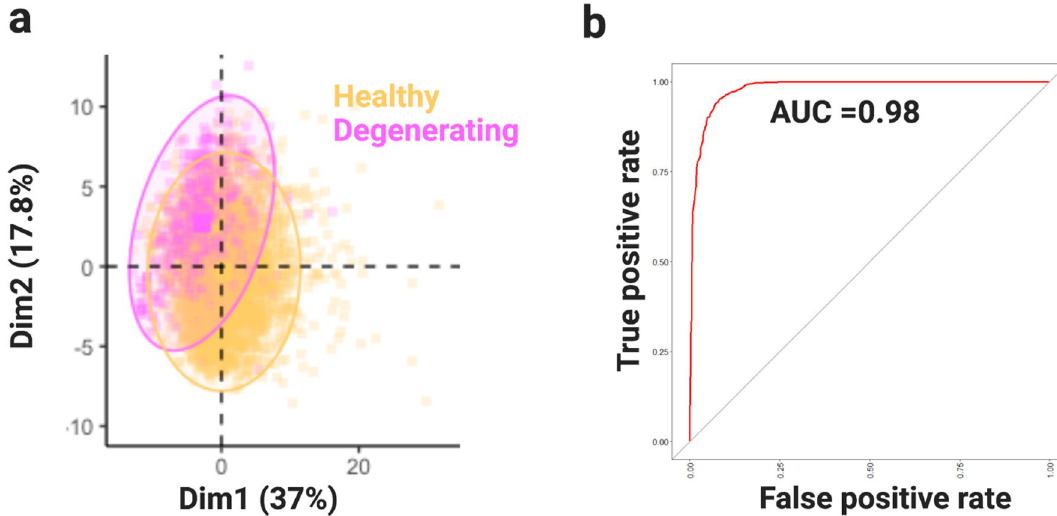
Figure 5. Machine learning algorithm accurately diagnoses NMJ changing. ( a ) PCA plot displaying healthy (fully innervated) and degenerating (partially innervated and denervated combined) NMJs. ( b ) AUC plot illustrating the ability of the Random Forest algorithm to differentiate the between healthy and degenerating NMJs. Tenfold